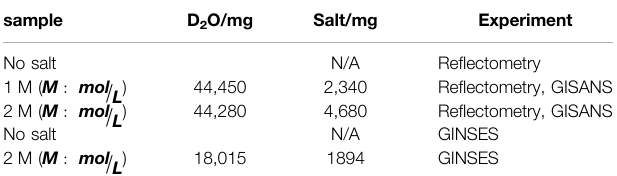
no salt was added to the sample, it was measured in pure D 2 O. sample